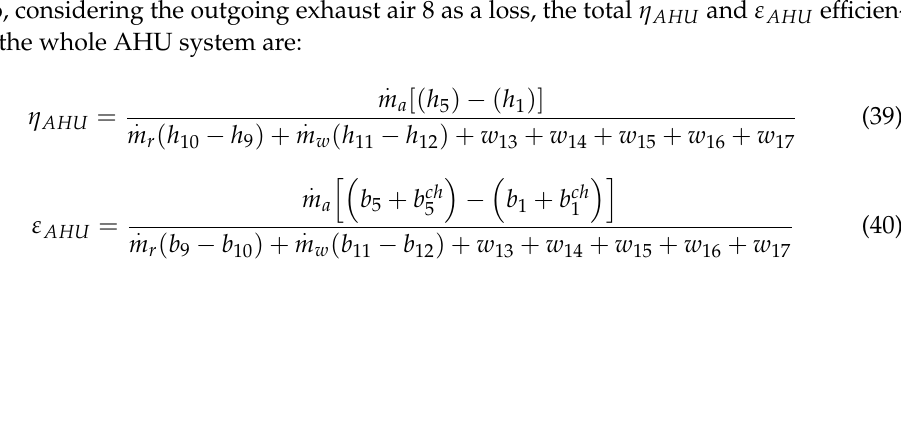
Figure 11. Flow numbering for energy and exergy analysis of the